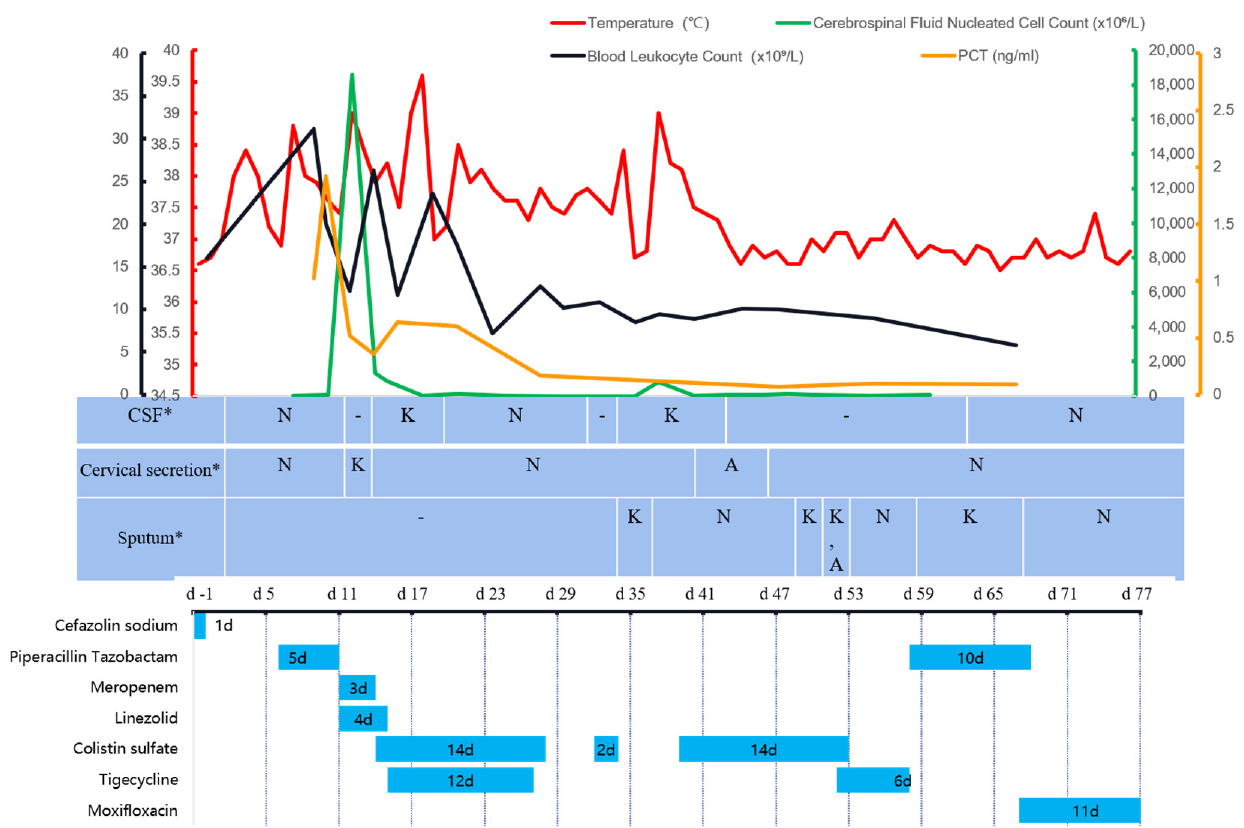
Figure 1. The temperature, cerebrospinal fluid nucleated cell count, blood leukocyte count, PCT, culture results of specimens sent, and the use of antimicrobials during hospitalization. Description: PCT: procalcitonin; CSF: cerebrospinal fluid; K: carbapenem-resistant Klebsiella pneumoniae ; A: car-